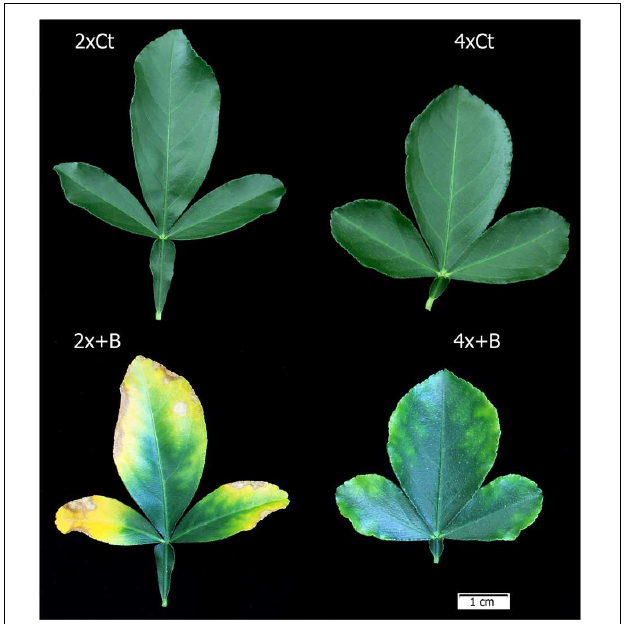
FIGURE 7 | Visual symptoms of B toxicity in leaves from the 6-month-old 2x and 4x CC seedlings grown in greenhouse conditions (Experiment 2) for 10 weeks in nutrient solutions added with 50 µ M (Ct) and 800 µ M H 3 BO 3 ( +